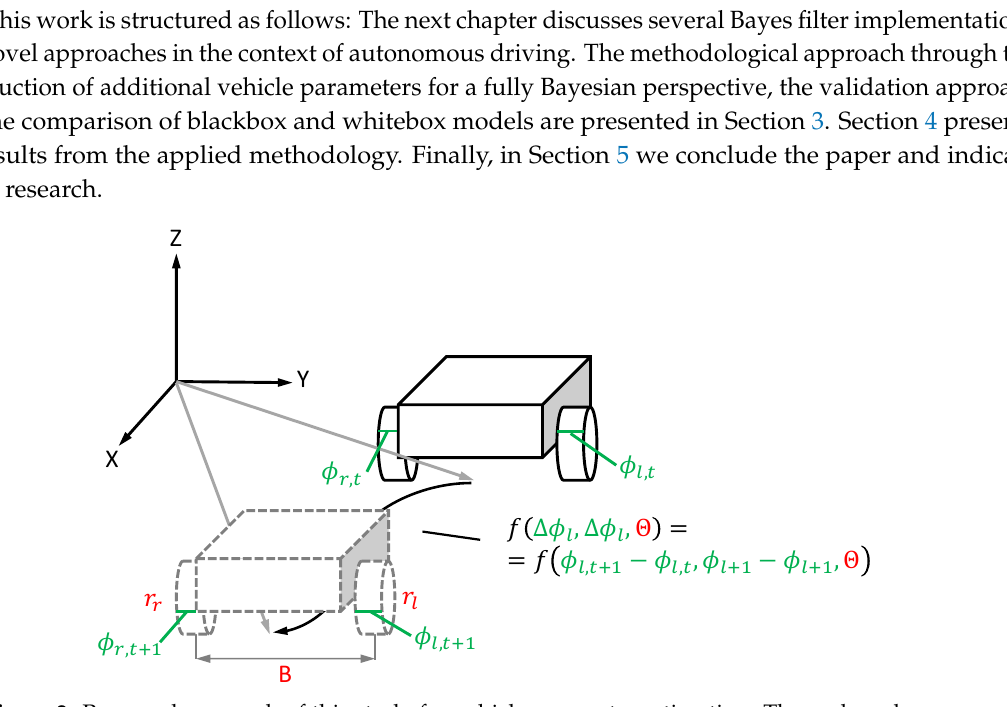
Figure 2. Proposed approach of this study for vehicle parameter estimation. The on-board sensory systems measure the wheel movement ( ∆ φ r and ∆ φ l ). Based on simulated global vehicle poses (gray arrows), we derive hidden vehicle parameters ( Θ = ( r r , r l , B )